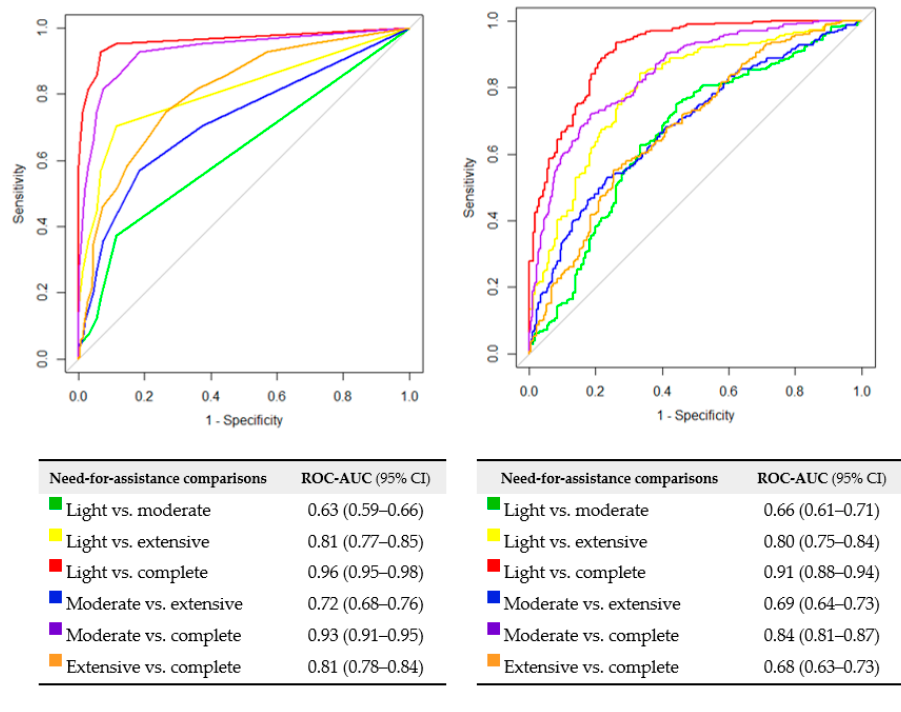
Figure 3 . Receiver operating characteristic (ROC) curves of comparisons between the resident need- for-physical-assistance scale’s categories for ( A ) observed number of handlings and ( B ) observed duration of care. The tables show the comparison between the categories, the area under the ROC curve (ROC-AUC) value and 95% confidence intervals (95% CI) for each comparison.